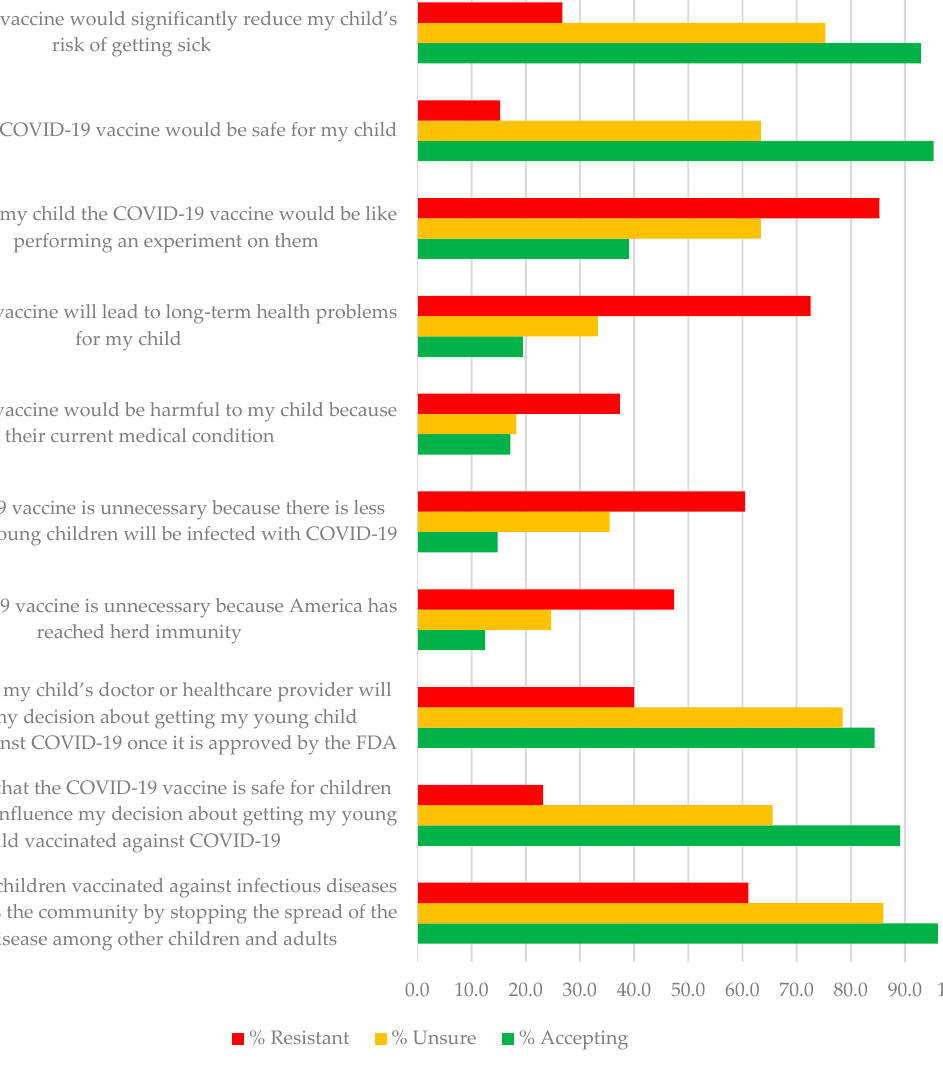
Figure 1. Percent of resistant, unsure, and accepting parents reporting agreement with COVID-19 pediatric vaccination survey items.